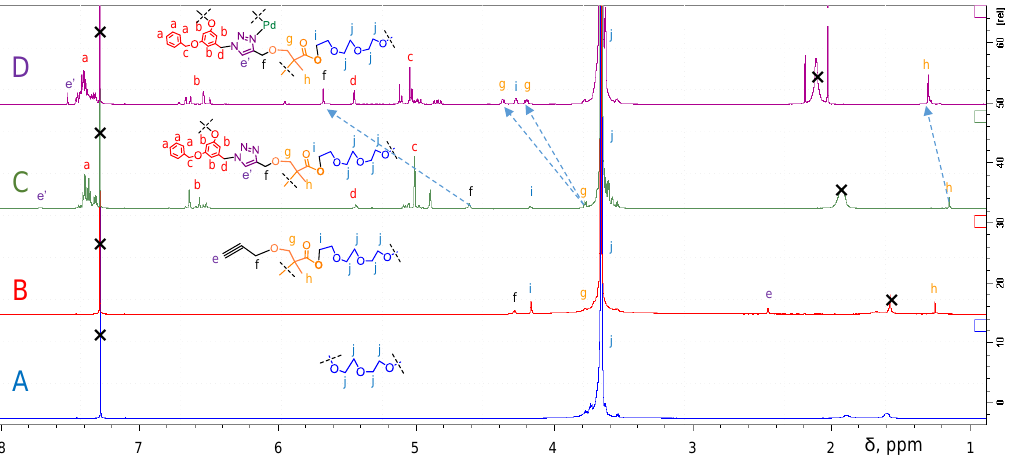
Figure 1. 1 H NMR spectra of PEG5k ( A ), bis-alkyne PEG5k ( B ), (G1) 2 − PEG5k − (G1) 2 ( C ) and (G1) 2 − PEG5k − (G1) 2 /Pd complex ( D ). Blue labels: PEG protons, orange labels: bis-PPA protons, purple labels: methine/triazole protons, red labels: poly(benzyl ether) dendron protons. × —solvent protons. See Section 2.2.3. in ‘Materials and Methods’ for analysis conditions.